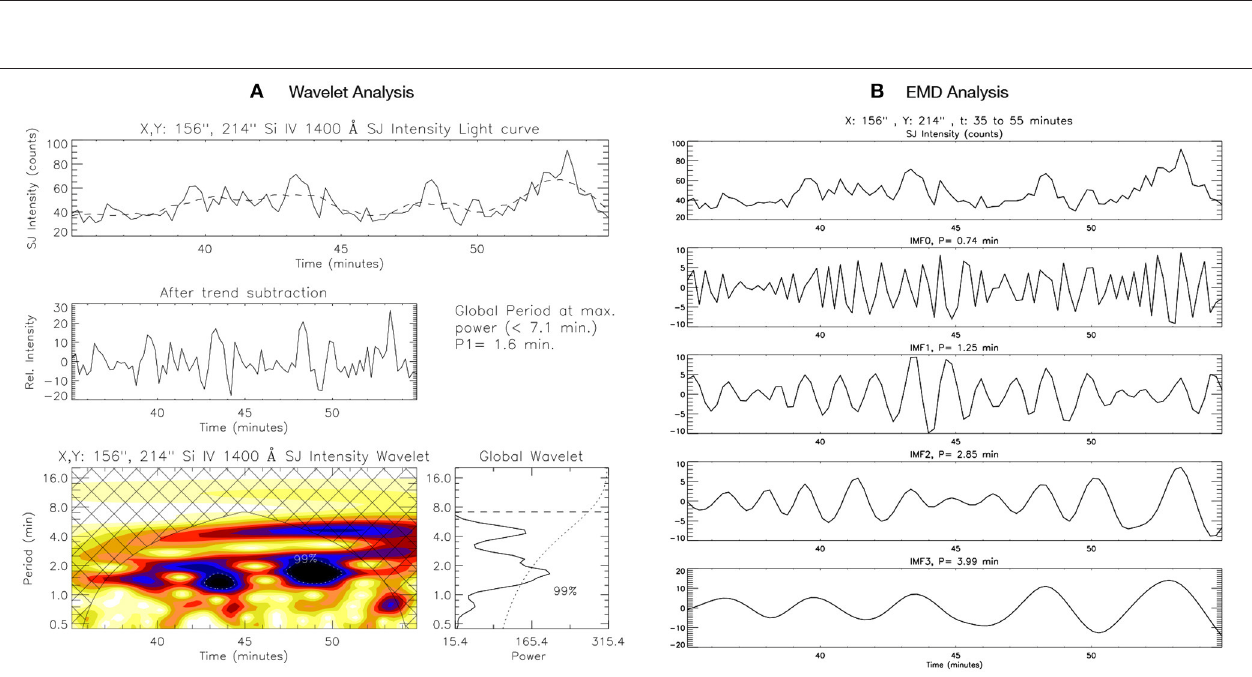
FIGURE 2 | (A) Wavelet analysis, and (B) EMD analysis result for the SiIV1400Å SJ intensity variation with time from 35 to 55 min of the observation at location A. The details about the different panels are explained in the text (section 3.1).